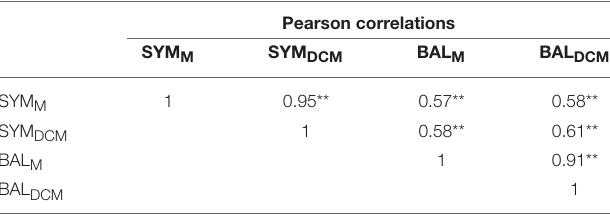
TABLE 6 | Intercorrelations between the different measures of visual balance for all 679 photographs. Pearson